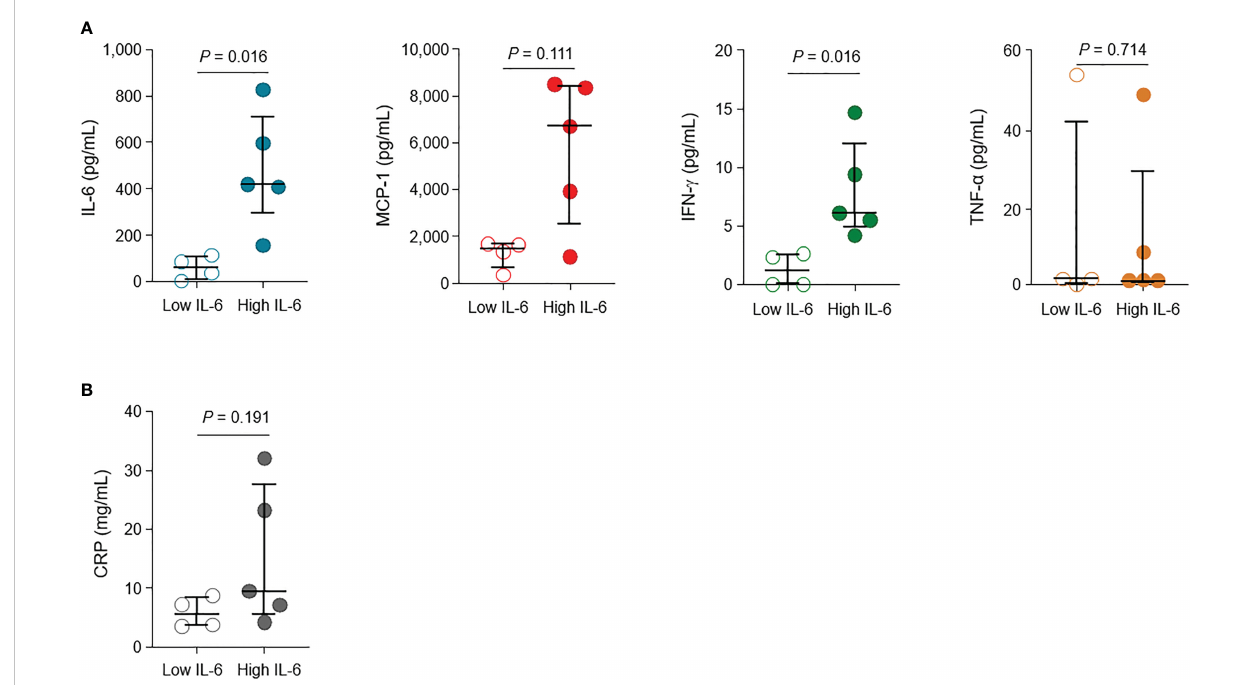
FIGURE 1 Levels of cytokines and in fl ammatory marker in patients with critical COVID-19. (A) The levels of interleukin (IL)-6, monocyte chemoattractant protein (MCP)-1, interferon (IFN)- g , and tumor necrosis factor (TNF)- a in the high IL-6 ( n = 5) and low IL-6 ( n = 4) groups. (B) Levels of C-reactive protein (CRP) in the high IL-6 and low IL-6 groups. Vertical and horizontal lines indicate the median with the interquartile range. The cytokine and CRP levels at the closest point to the onset of critical illness (within 0 – 5 days of high fl ow nasal cannula oxygen therapy initiation) are